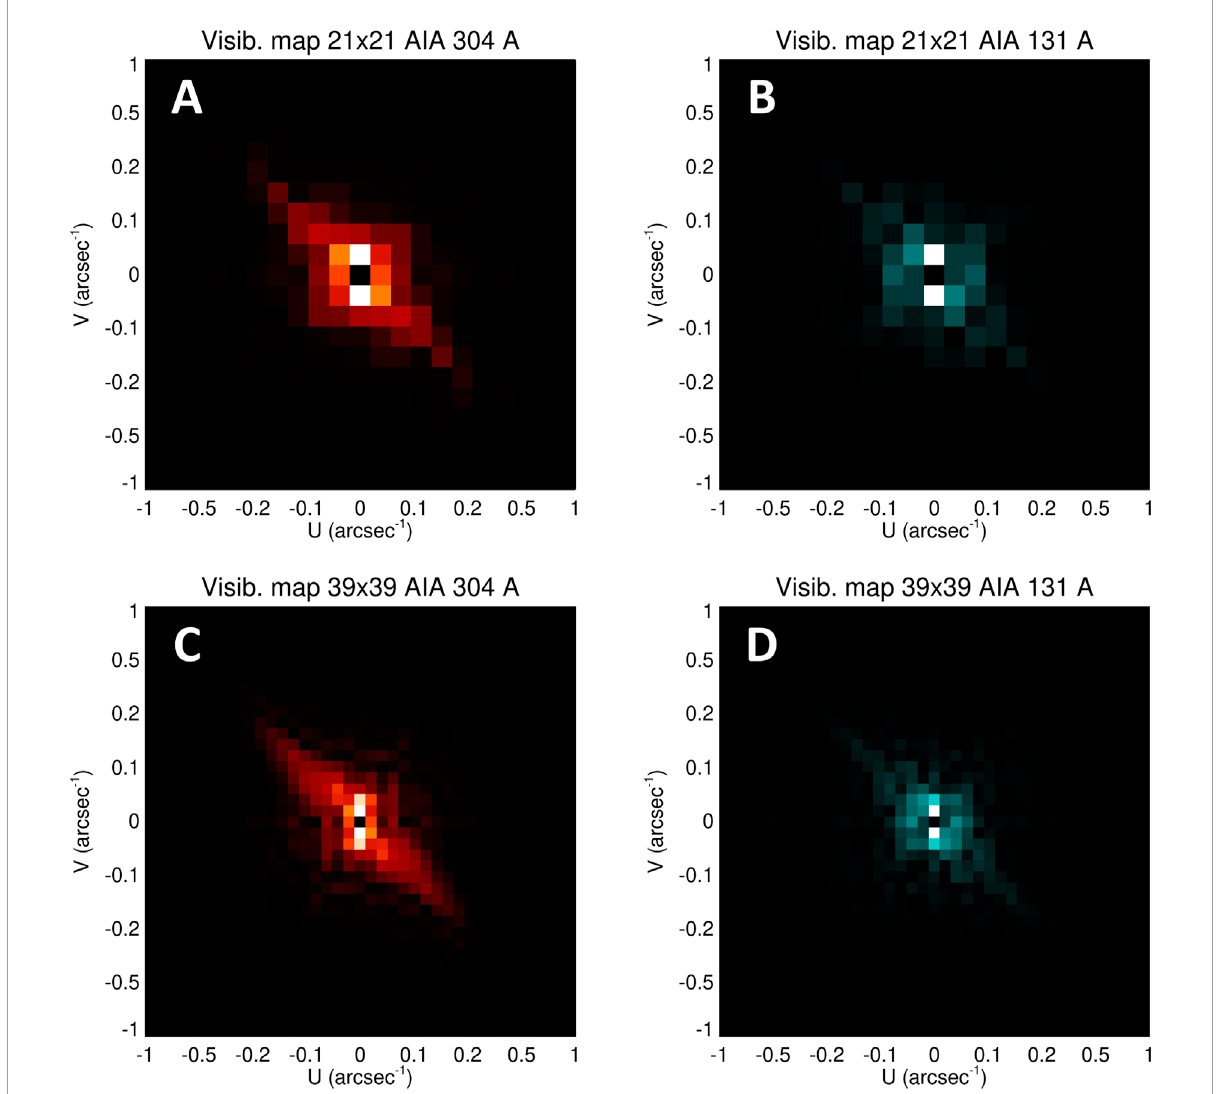
FIGURE 5 Spatial Fourier transform (“visibility”) amplitude maps of the images in Figure 1 , using Eq. 2 applied at the spatial frequency ( u , v ) points shown in both panels of Figure 4 . Panels (A) and (B) contain 21 × 21 points, while panels (C) and (D) contain 39 × 39 points,